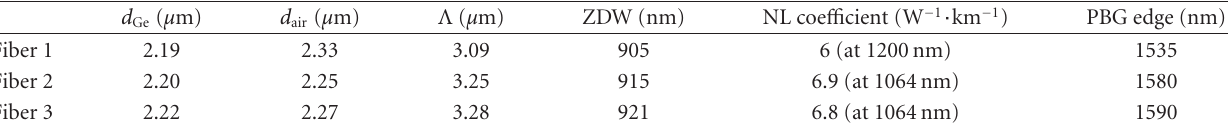
Table 1: Table summarizing the optogeometrical properties of the three fabricated solid-core PBG fibers under investigation.